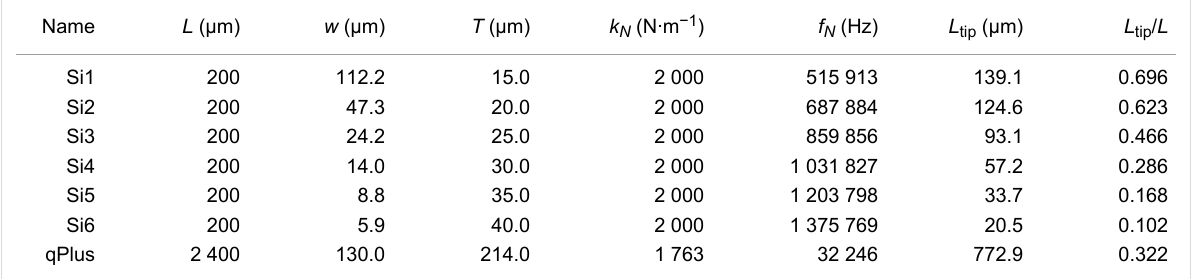
Table 1: Dimensions and dynamic properties of silicon microcantilevers that would provide normal spring constants of 2 kN·m − 1 . L tip is the tip length required to provide a lateral spring constant of 2 kN·m − 1 . qPlus sensor is also included (the frequency is not 32768 Hz, as some features, such as base deformations and gold contacts, were neglected in the calculations).